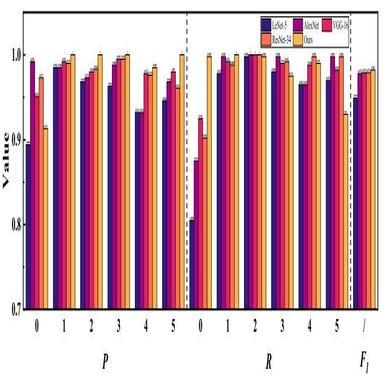
Diagram of evaluation metrics comparison results of five trained models.